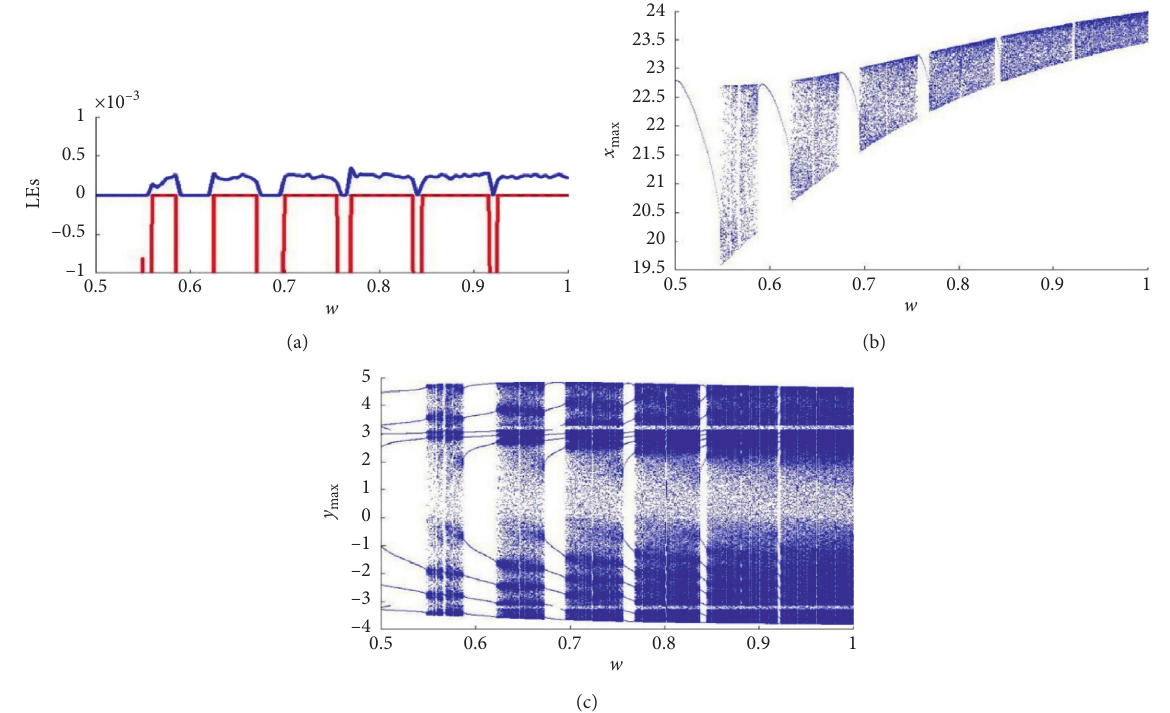
Figure 3: Lyapunov exponents and bifurcation diagrams when w changes as the bifurcation parameter. A and initial conditions are set 1 and ( 0 . 01 , 0 ) , respectively. (a) The two largest Lyapunov exponents are shown and zoomed. Therefore, parts of the third, which is negative, and its absolute value is larger than the two others, are not plotted. Also, parts of the second Lyapunov exponent cannot be seen because of the zoom for better visualization. (b) Peaks of the x variable time series. (c) Peaks of the y variable time